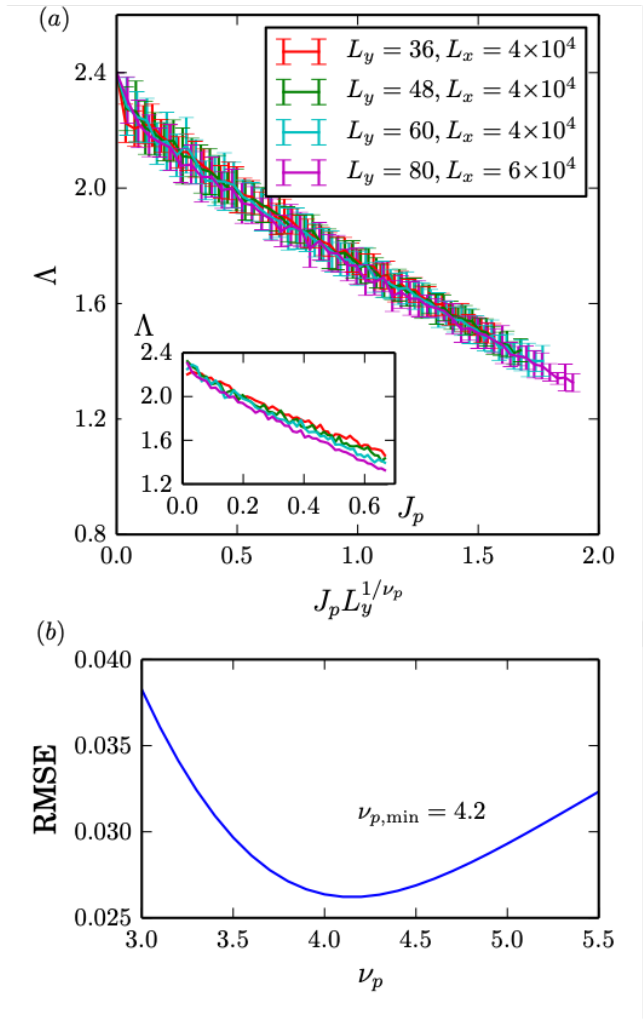
1 /ν p L with optimal ν from (a). Inset: the unscaled y p p 1 /ν p L should be the same for all L y p